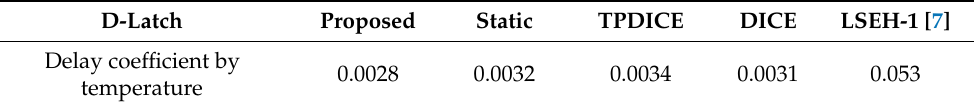
Table A1. Comparative delay coefficient by temperature of